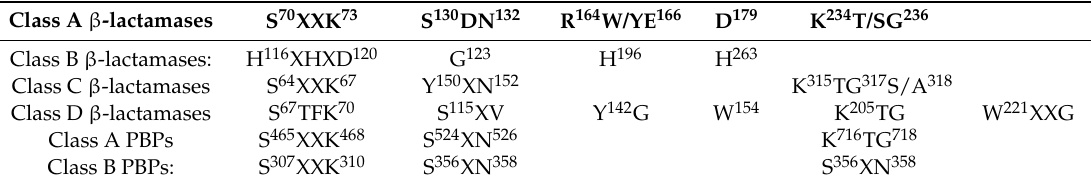
Table 3. The list of active site residues discussed in this paper.